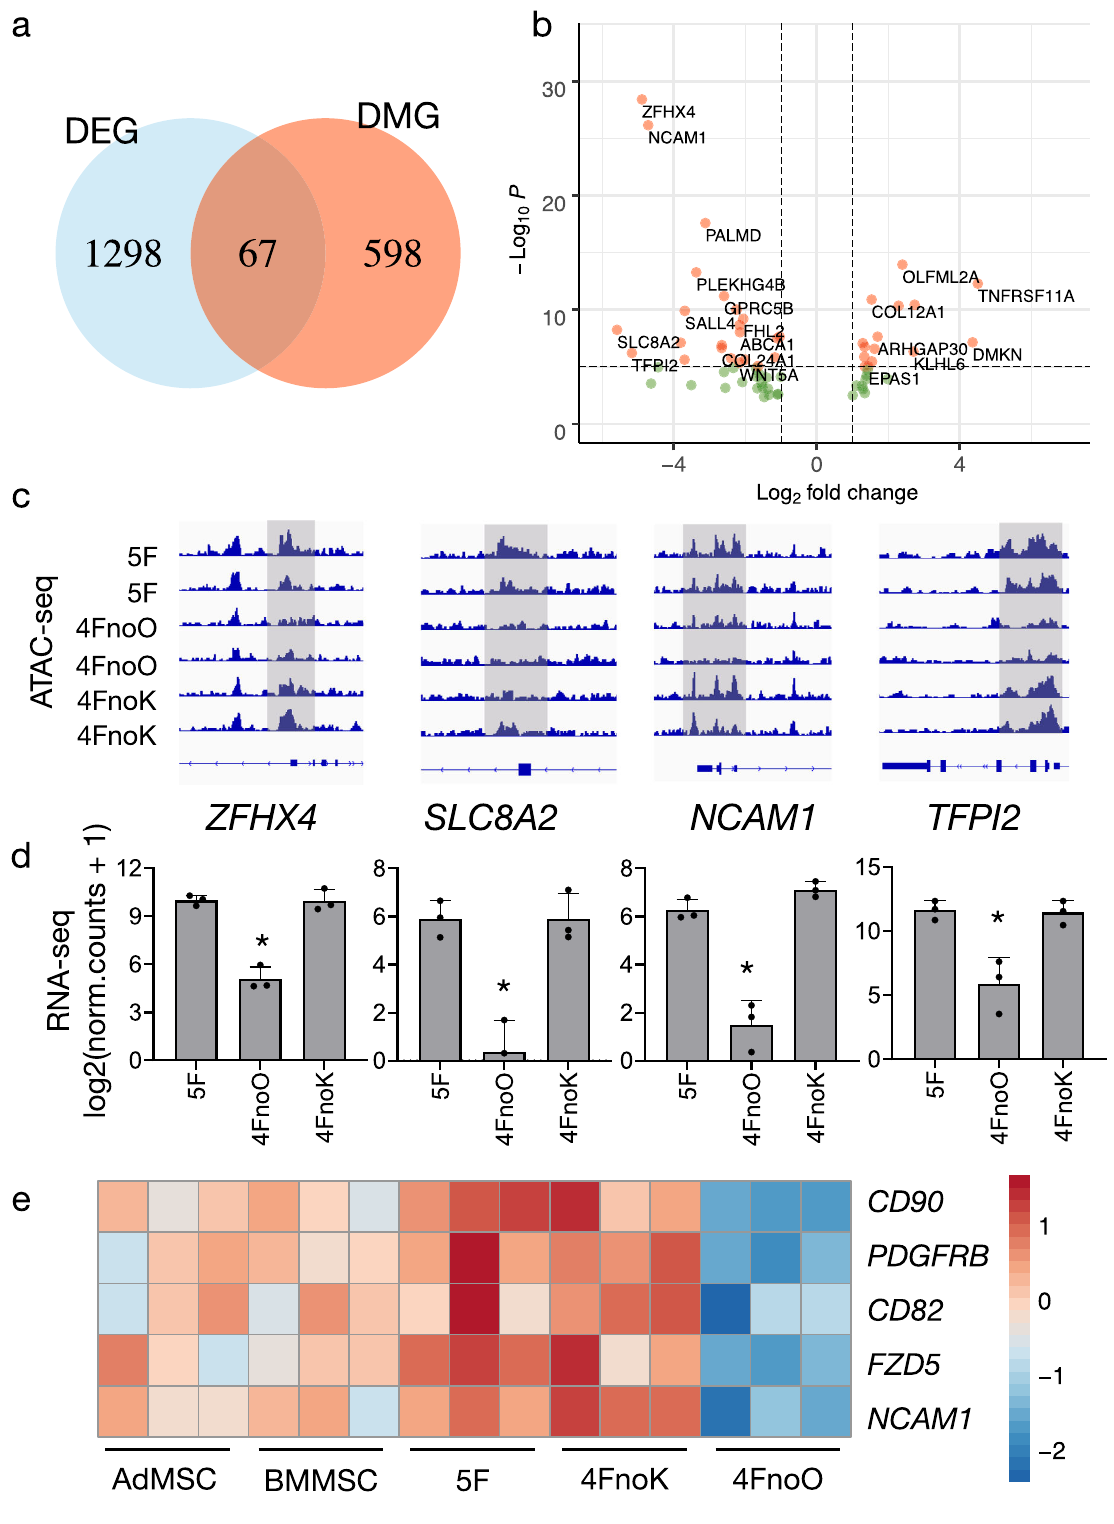
Fig. 7 Integrated analysis of multiomics data identi fi es putative MSC markers. a Venn diagram illustrating the overlap between the differentially expressed genes (DEGs) and differentially methylated genes (DMGs) between 5F iMSCs and 4FnoO iMSCs. A total of 1365 DEGs and 665 DMGs were identi fi ed; 67 of these were both differentially expressed and differentially methylated. b Volcano plot showing 67 overlapping genes between the DEG and DMG. pCutoff = 10e − 6 , log 2 FC > 1). c Selected genomic views of the ATAC-seq data using IGV (2.8) for the indicated groups. For each gene, all genome views are on the same vertical scale. d The bar plot showing the RNA-seq gene expression values for the respective genes, which are shown above in the genome view. RNA-seq gene expression levels are shown as log 2 () normalized read counts. *, P < 0.05; error bars indicate standard deviation. n = 3 biologically independent samples for each group. e Heatmap showing the normalized gene read count after log 2 () transformation from RNA-seq. COMMUNICATIONS BIOLOGY| (2023) 6:393